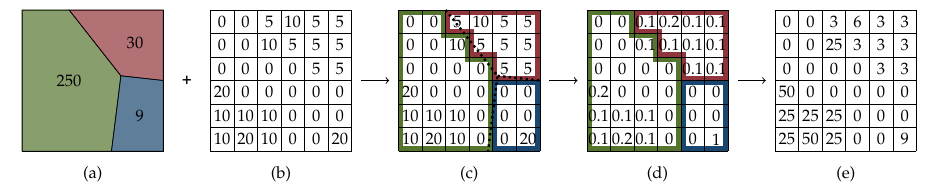
Figure 1. Zonal disaggregation process. Input features ( a ) and population raster ( b ) are overlaid ( c ), and the population raster cells normalized by feature ( d ) before multiplying with the individual feature’s population numbers ( e ).